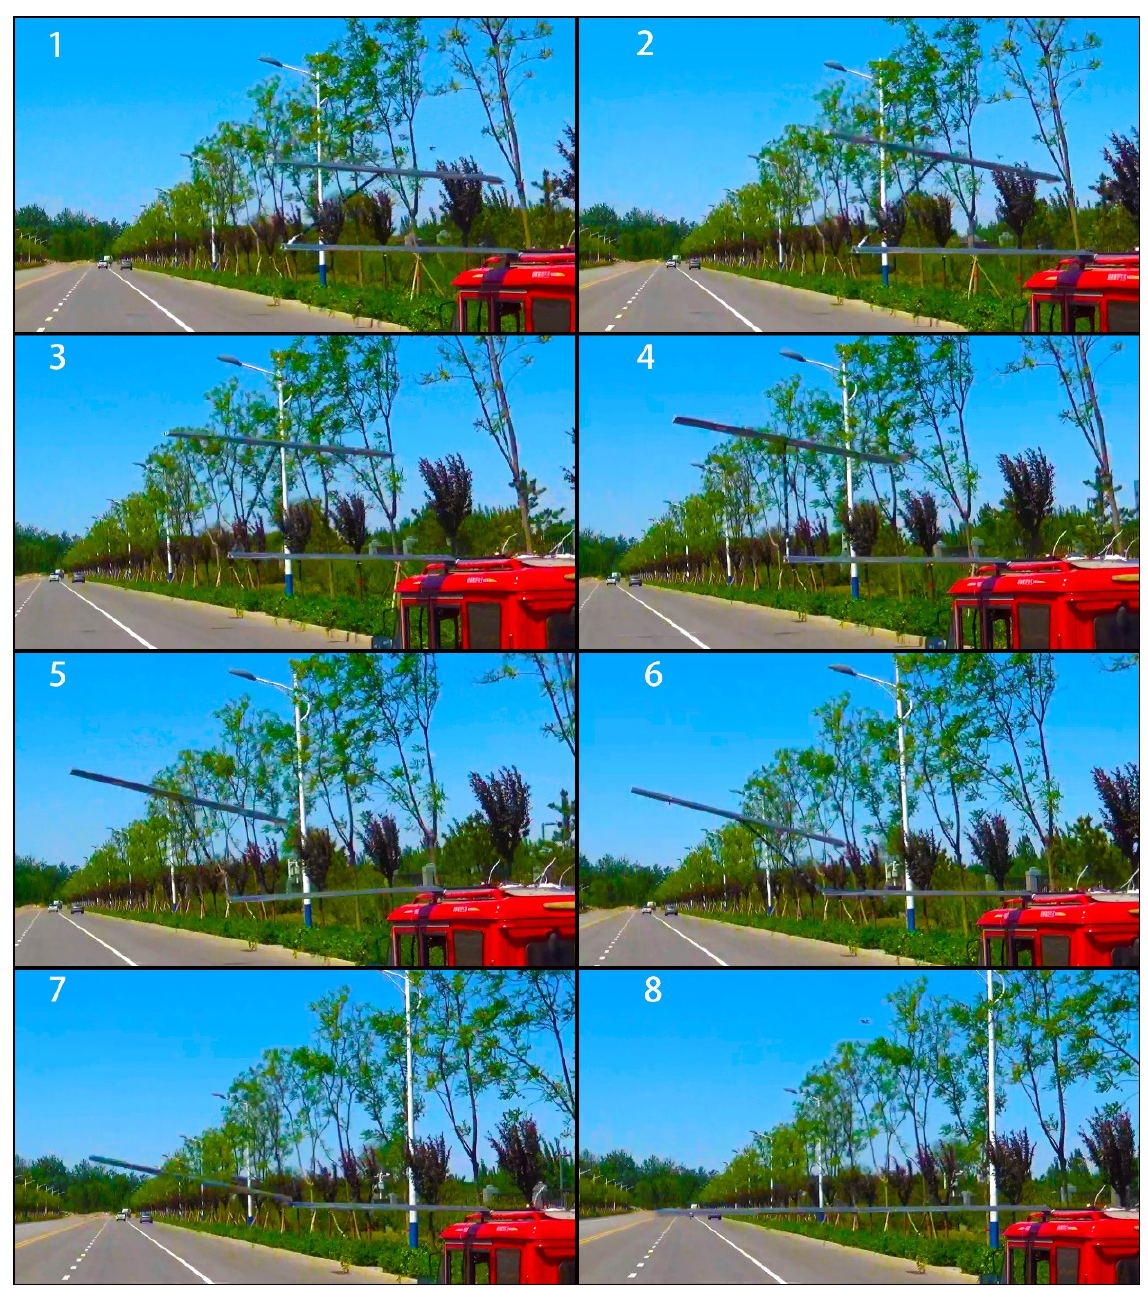
Figure 7. The unfolding process of the wings. 1 – 8 shows the process of morphing in chronological order .